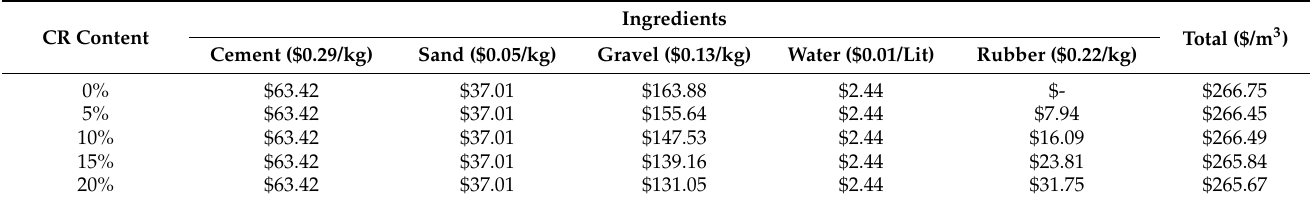
Table 3. The unit cost of different concrete mixtures and their ingredients.